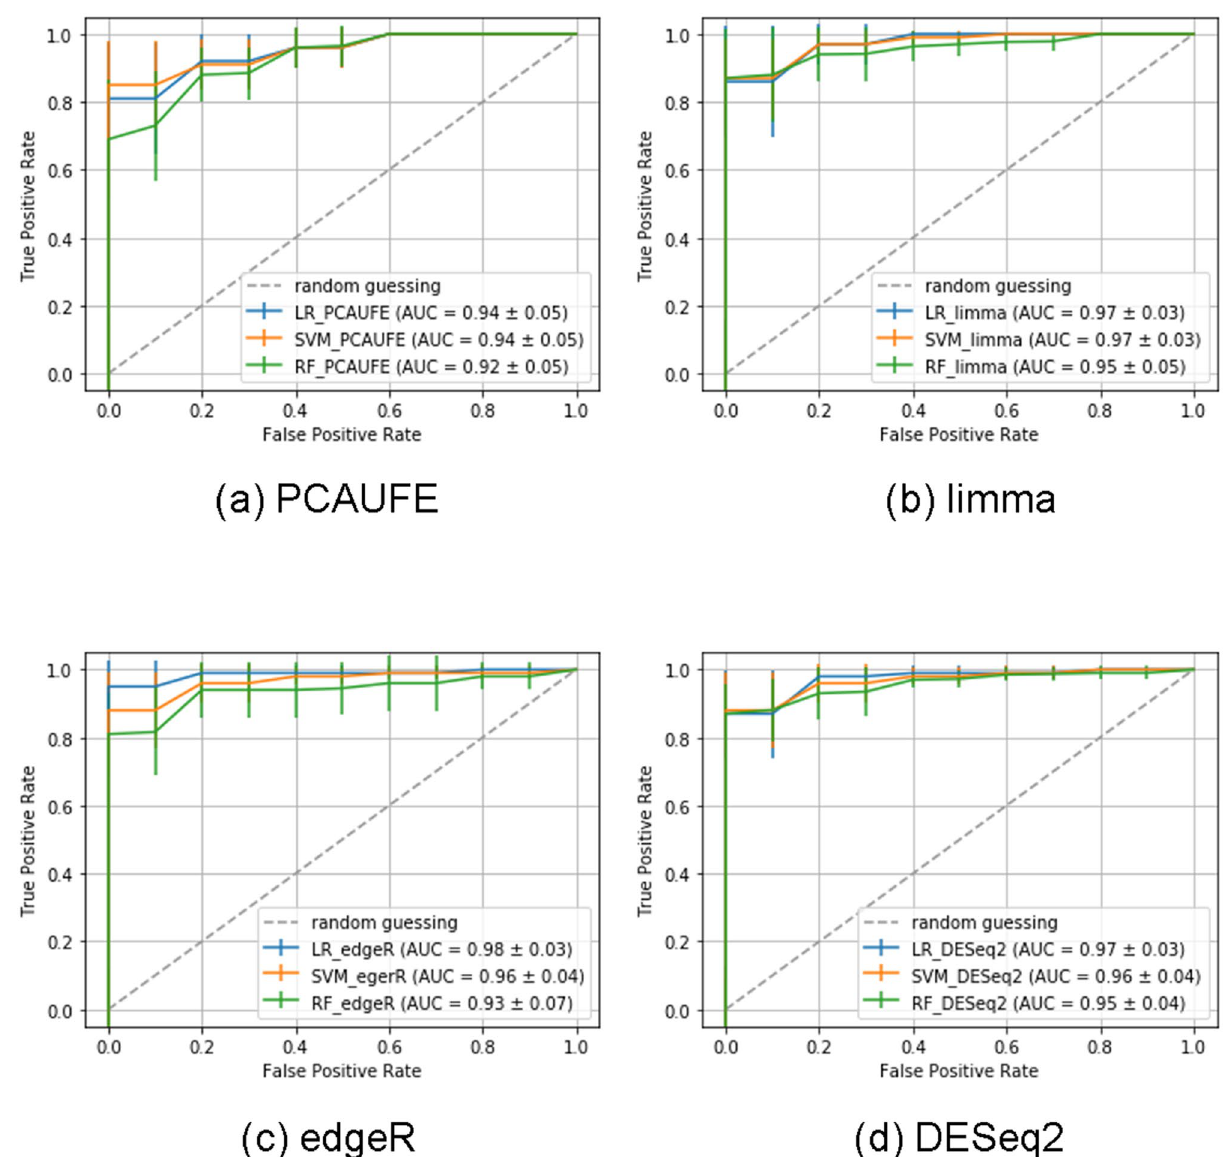
Figure 2. ROC curves of each classification model to predict COVID-19 patients or not based on the probes selected by ( a ) PCAUFE, ( b ) LIMMA, ( c ) edgeR, and ( d ) DESeq2, respectively. Note that since the number of probes respectively selected by LIMMA, edgeR, and DESeq2 were all above 4000, too much more than the samples, the probes with the smallest adjusted. P values were further restricted to be almost the same number as in PCAUFE, 141, for the explanatory variables. Using each classification model, we respectively performed fivefold cross-validation and reported the averages and standard deviations of the 5